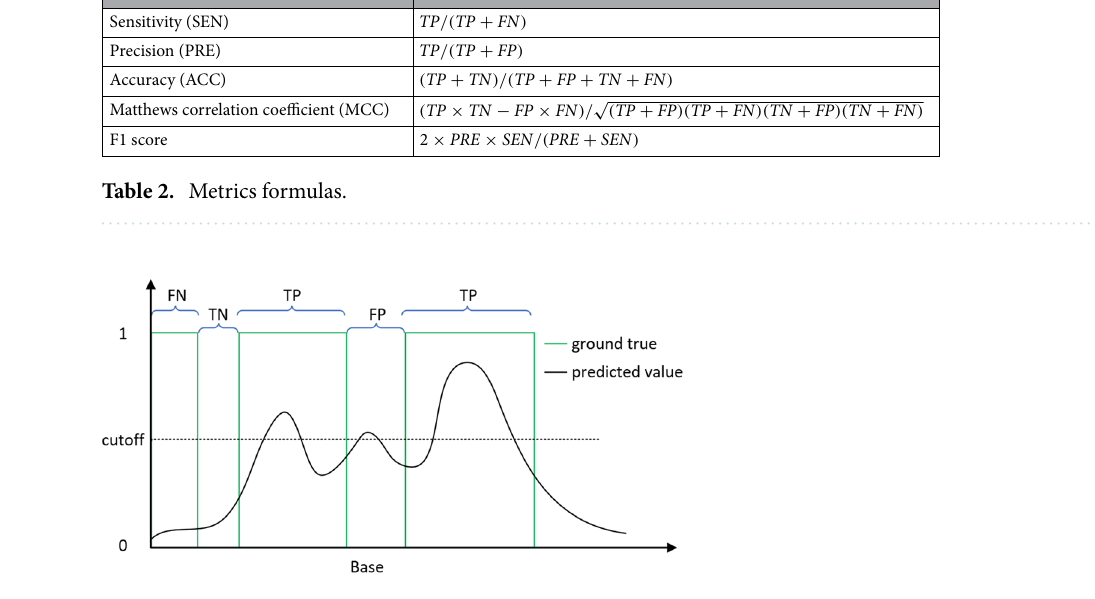
Figure 4. Segment-based metrics. A segment is considered as a TP if one or more bases are correctly predicted in the region of an exterior loop, otherwise, it is considered as an FN. A segment is considered as an FP if one or more bases are incorrectly predicted in the region of the non-exterior loop, otherwise, a TN is